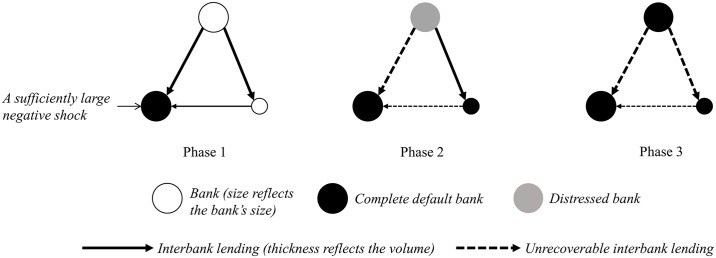
Sketch map of risk contagion.